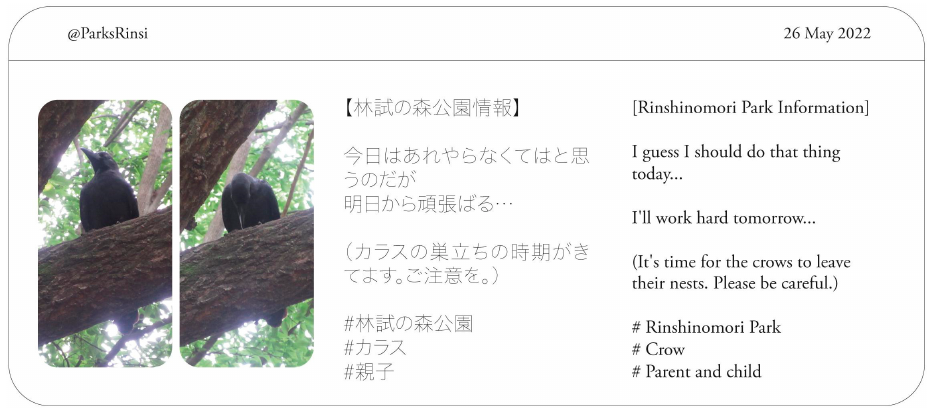
7 of 16 Table 1. Main actors count. Human Main Actor